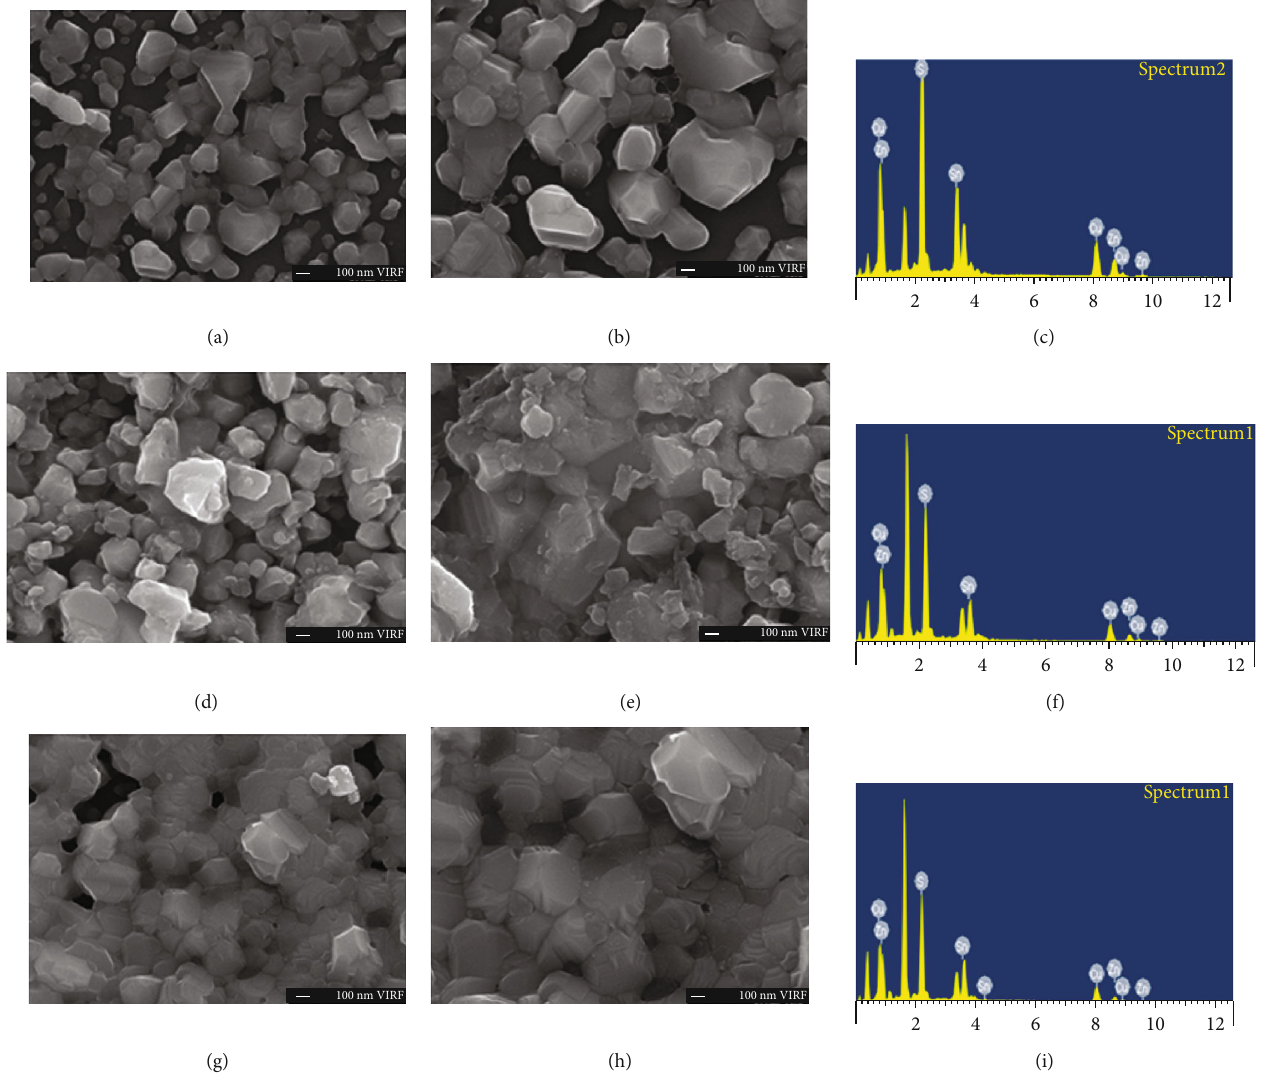
Figure 3: (a – i). FE-SEM and EDS patterns for the CZTS, CZTS-PVA, and CZTS-DMSO thin fi